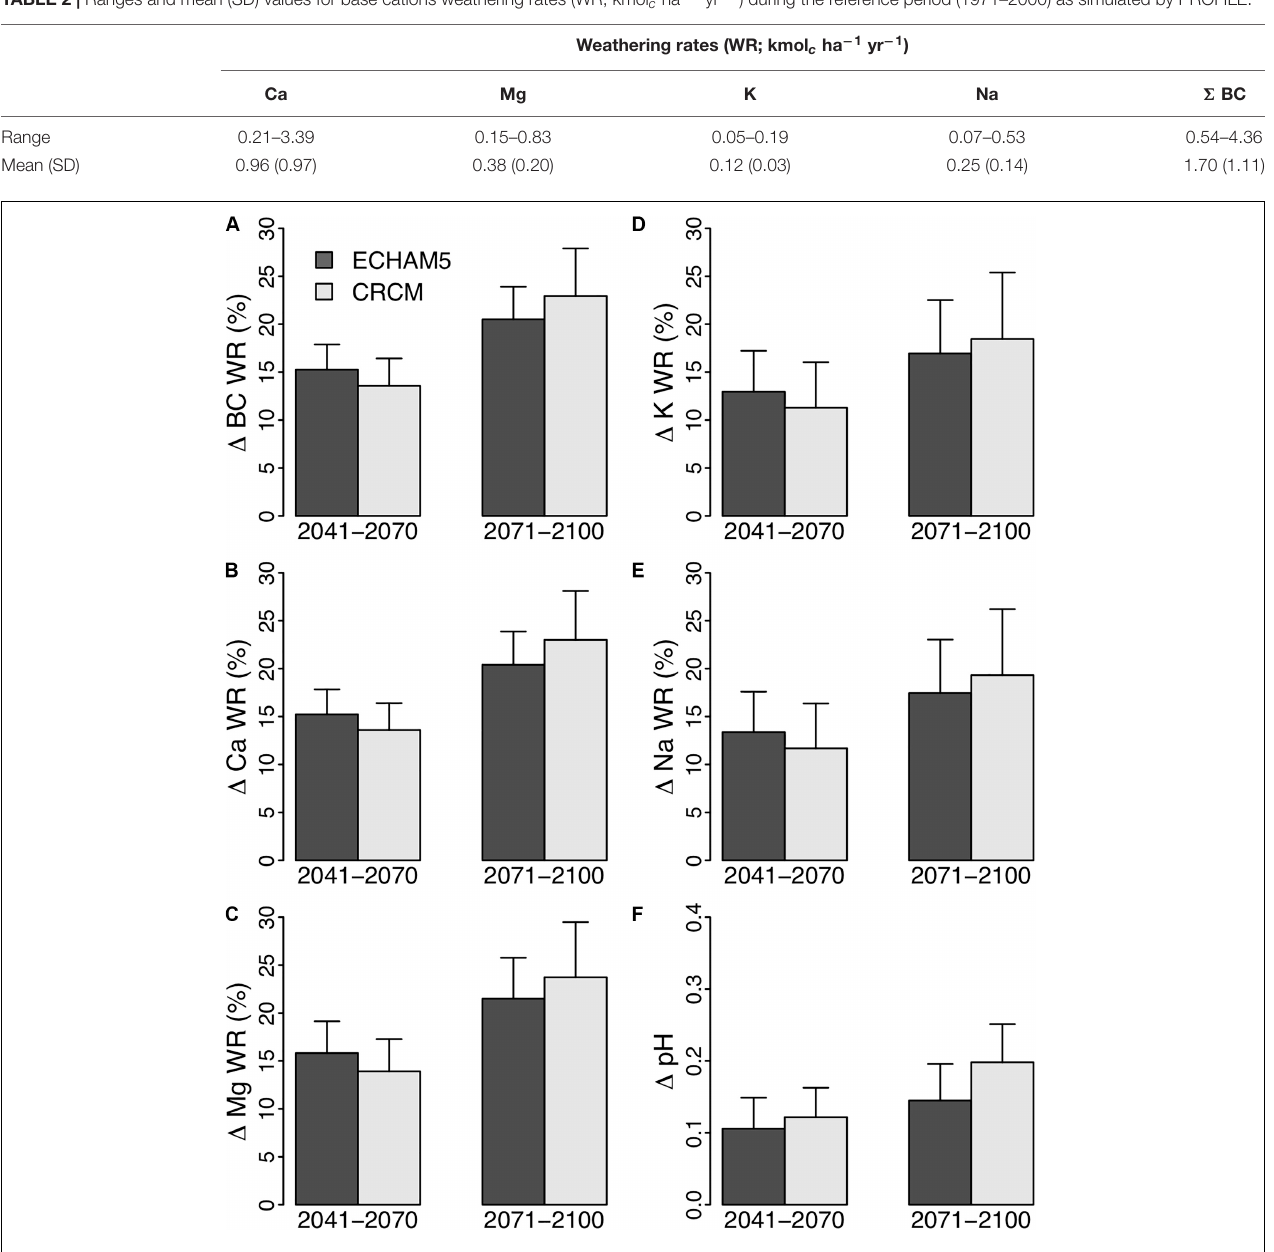
TABLE 2 | Ranges and mean (SD) values for base cations weathering rates (WR; kmol c ha − 1 yr − 1 ) during the reference period (1971–2000) as simulated by PROFILE.